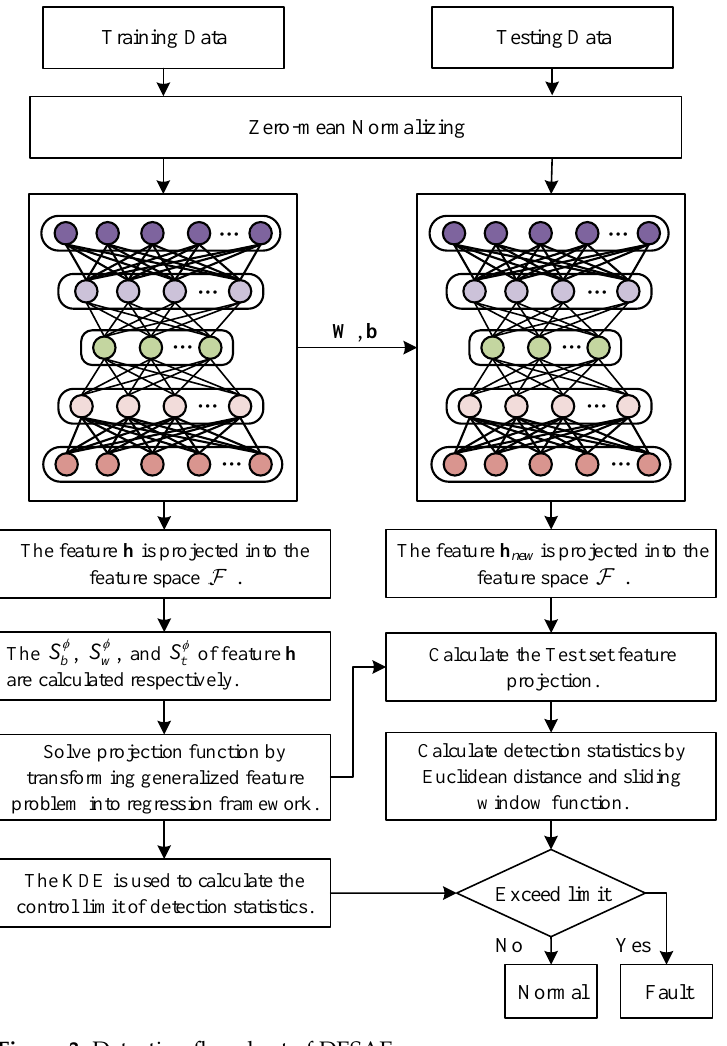
Figure 3. Detection flowchart of